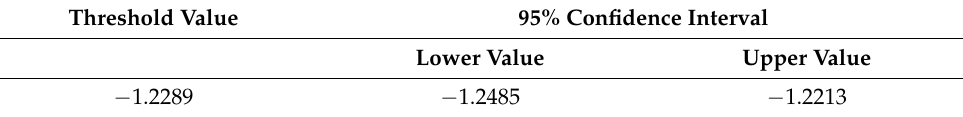
Table 10. Threshold